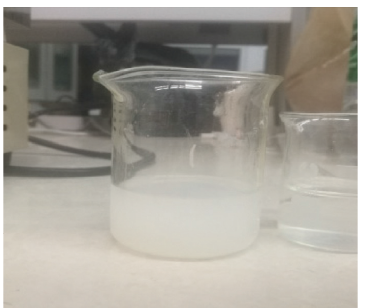
Figure 2: TBP/OK and H